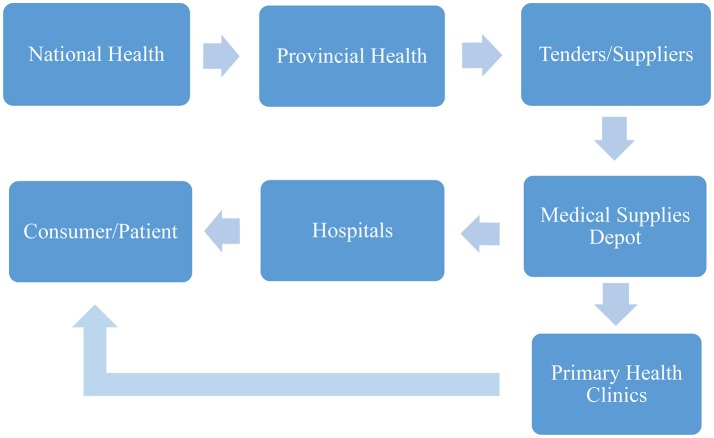
End-to-end pharmaceutical supply chain steps in SA (34).